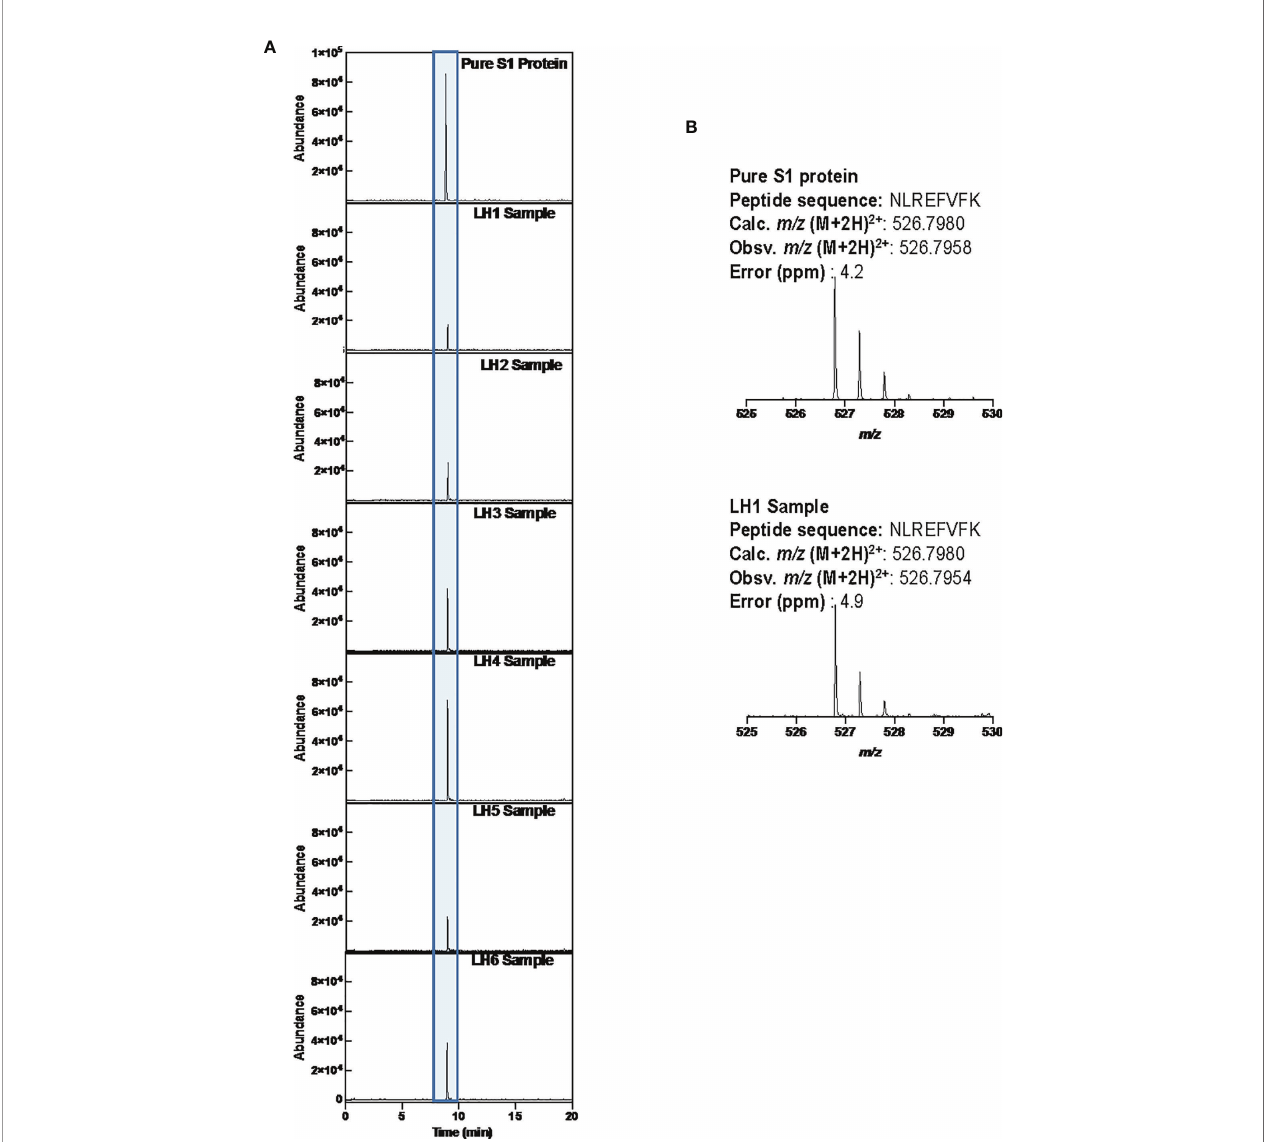
FIGURE 4 | LCMS con fi rmation of the presence of S1 subunit in samples LH1-6. (A) Extracted ion chromatogram (EIC) displaying the NLREFVFK peptide. The retention time matches that of the NLREFVFK peptide in the commercial S1 standard. (B) Mass Spectra of the NLREFVFK from both the commercial standard and patient LH1. The Spectra show the same mass and isotope distribution.